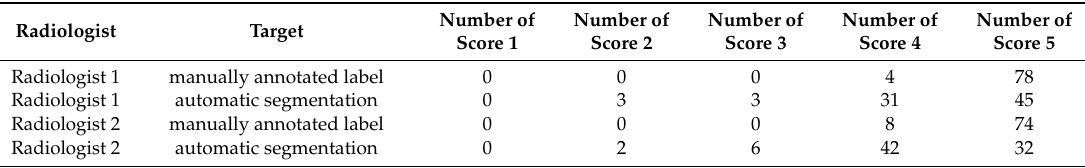
Table 1. Results of qualitative evaluation of automatic pancreas segmentation and manually annotated